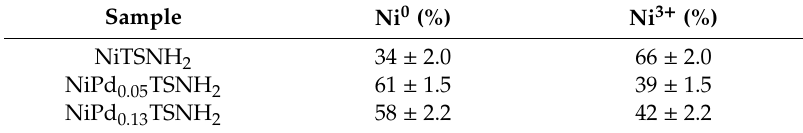
Figure 6. Ni K X-ray absorption spectrum measured for ( a ) NiTSNH 2 ; ( b ) NiPd 0.05 TSNH 2 ; and ( c ) NiPd 0.13 TSNH 2 . The solid lines present the best fit of a linear combination of Ni 0 and Ni 3+ reference XAS spectra to the measured data. Table 4. Contribution of Ni 0 and Ni 3+ species extracted from Ni K-edge XAS spectra.